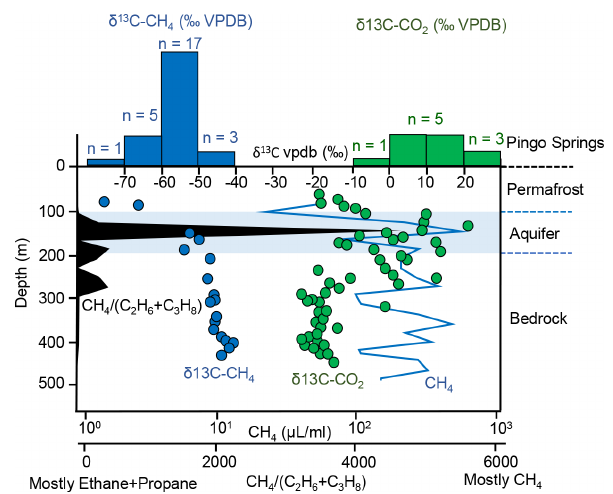
Figure 4. Histograms showing the stable isotope composition of methane and CO 2 in pingo spring waters (from Table 2) for com- parison with published pore gases from different depths at the CO 2 Well Park (Well Site B in Fig. 2). The ratio of methane to the sum of ethane and propane (all in µLmL − 1 ) is shown to indicate where biogenic methane is most likely (i.e. high values). Also shown are the approximate lower boundary of the permafrost and the aquifer beneath